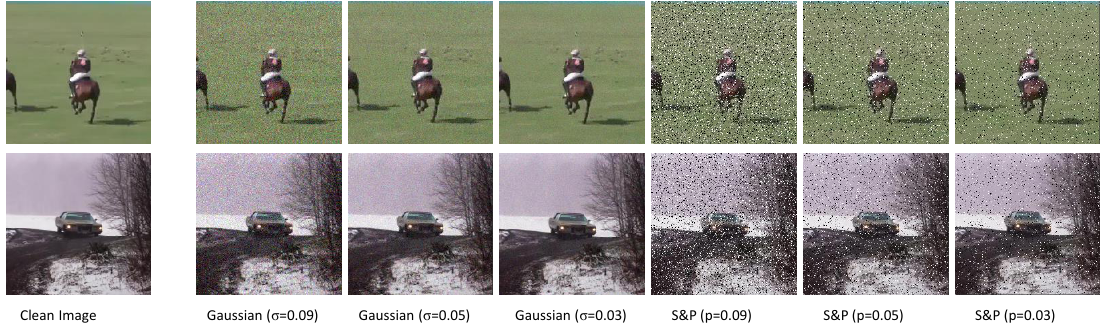
Figure 8. Illustration of additive noises to inputs. Here σ represents the variance of Gaussian noise while p denotes the probability for Salt and Pepper (S&P) noise.